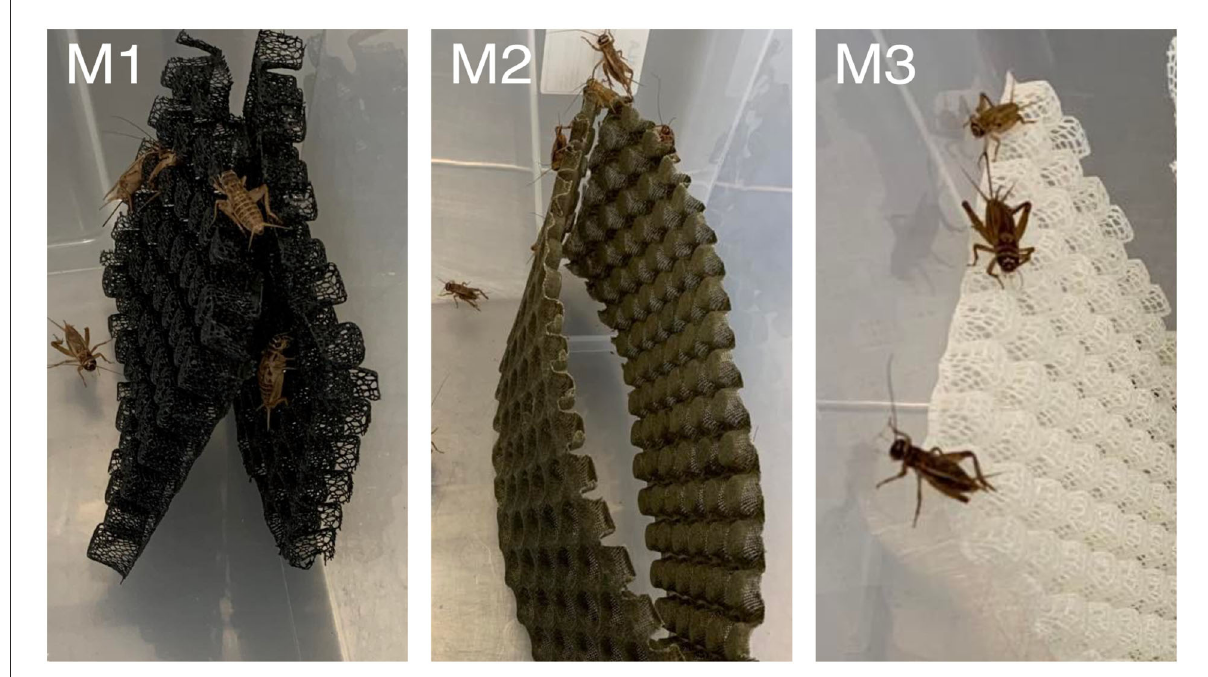
FIGURE3 Material test with Acheta domesticus . Adult crickets in direct contact with different materials